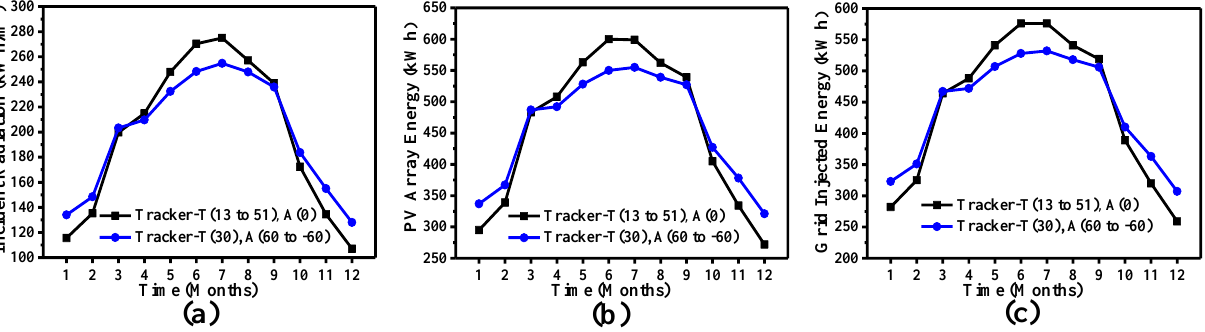
Figure 10: [Tracker-T(x), A(x, -x)] Configuration: (a) incident radiation received by the module surface, (b) generated energy by the array, and (c) energy injected to the grid.